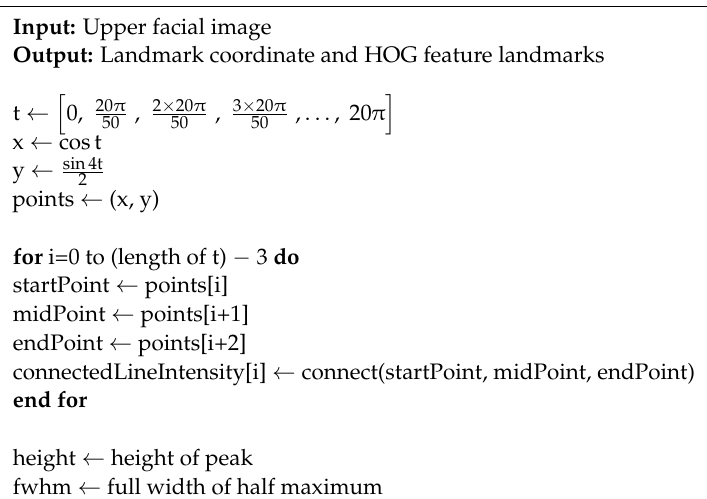
Algorithm 1: Landmark Detection and Feature